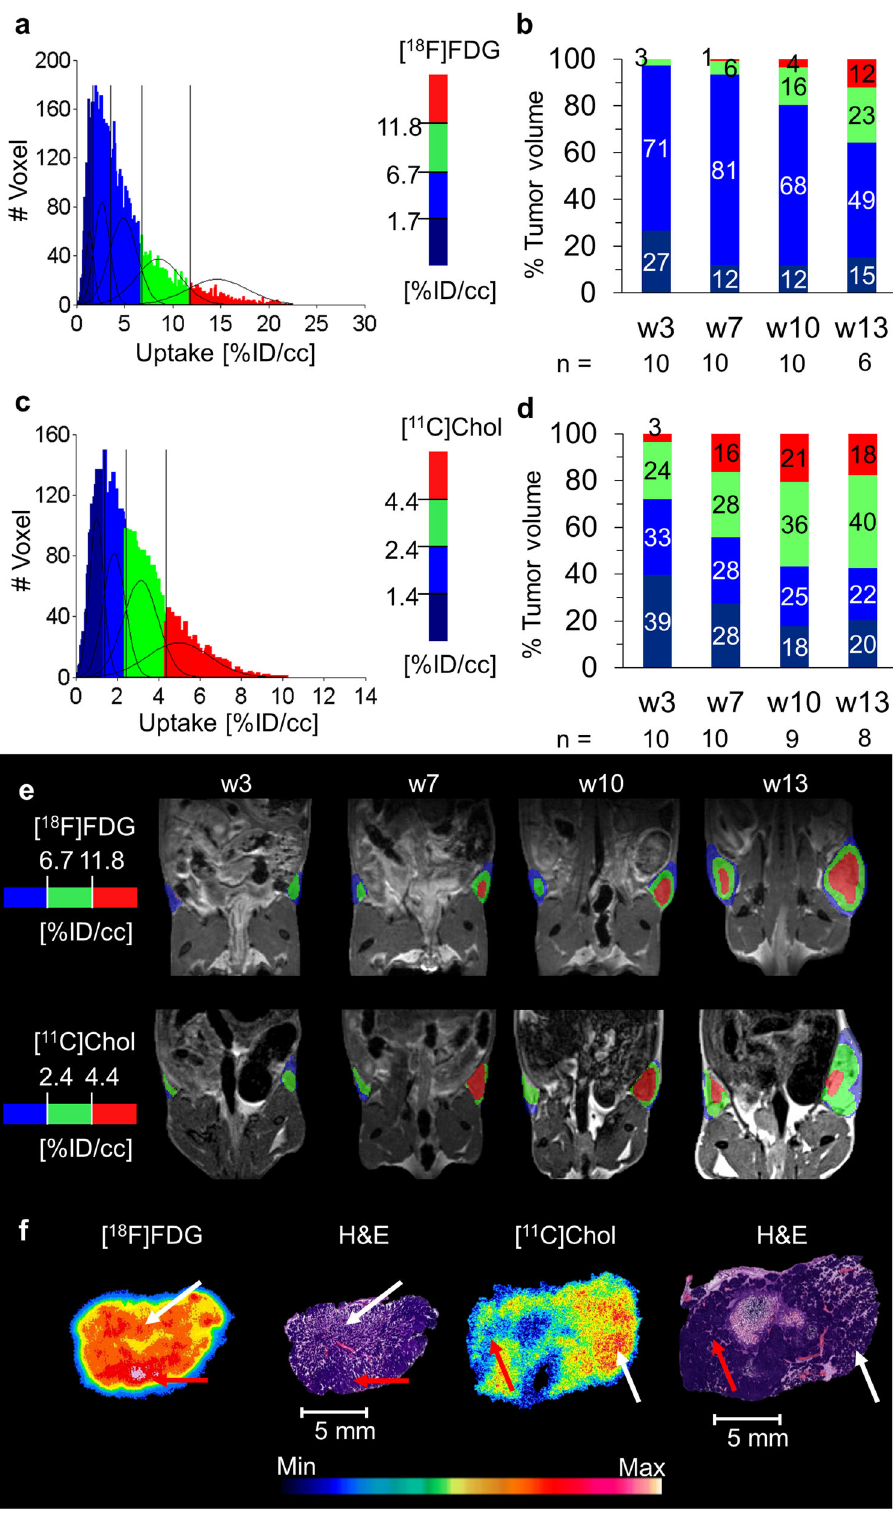
tissues was further impaired by potential vasculogenic mimicry 28